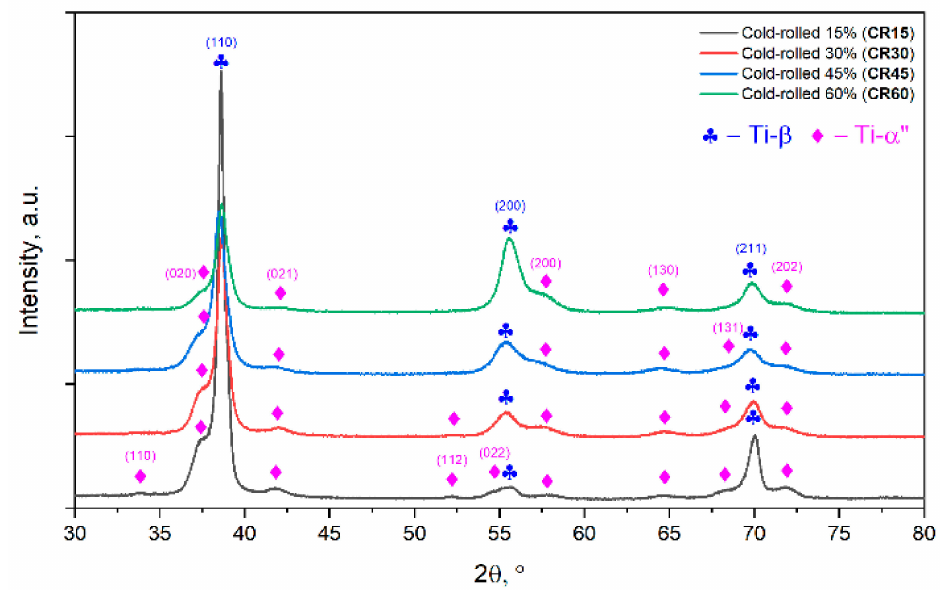
Figure 5. XRD spectra of the cold-rolled (CR) TNZT